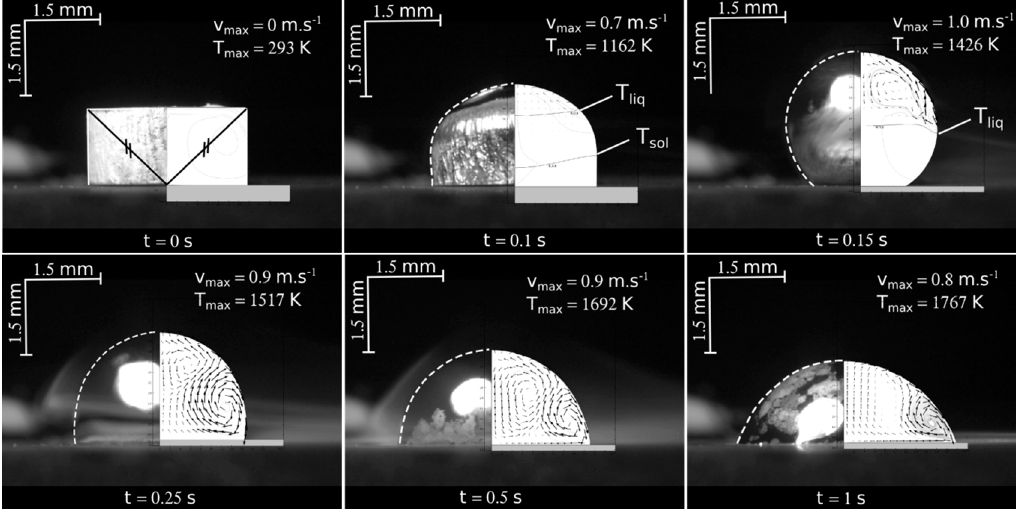
Figure 8. Experimental and numerical shapes comparison.